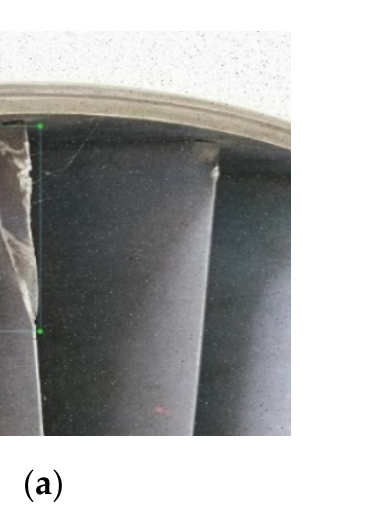
Table 2. The settings for the training